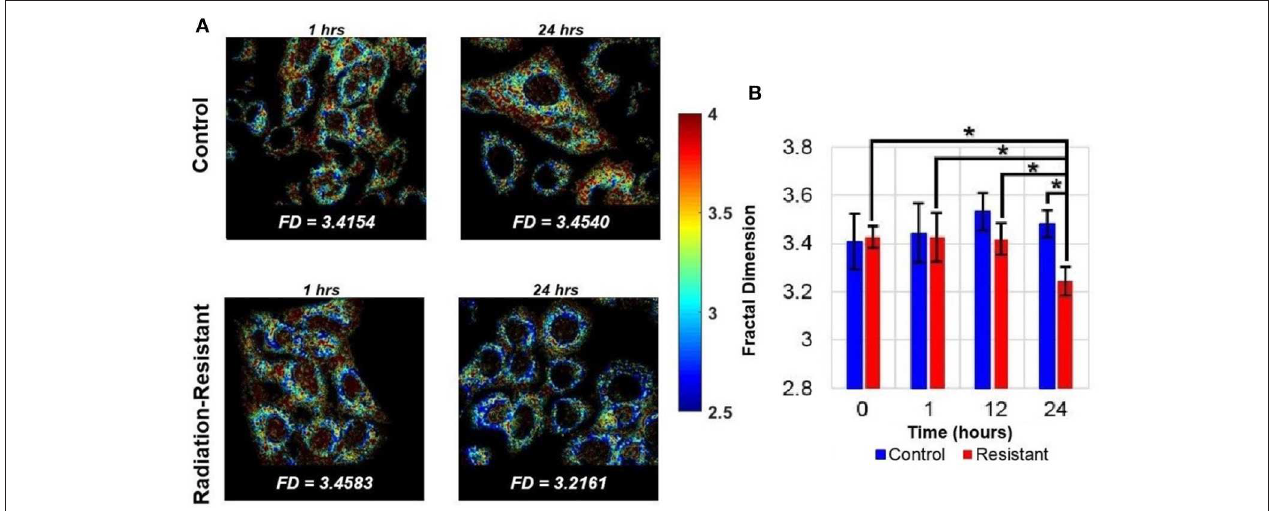
FIGURE 3 | Quantifying mitochondrial organization from NADH autofluorescence. (A) Representative FD maps corresponding to lung cancer cells of both control and radiation-resistant groups. The images were obtained at time periods of 1- and 24-h post radiation. (B) Summary data demonstrates significant temporal changes in the mitochondrial organization of radiation resistant cell line at 24h [Reproduced with permission from Vargas et al. ( 64)]. * p <